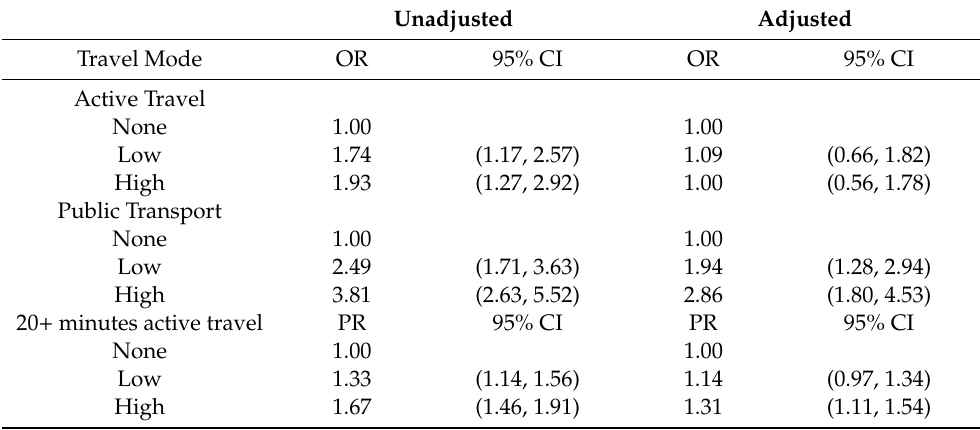
Table 2. Associations between public transport accessibility at home on the likelihood of taking active or public transport to school compared to cars, and the likelihood of achieving 20 min of active travel on the journey to school ( n =